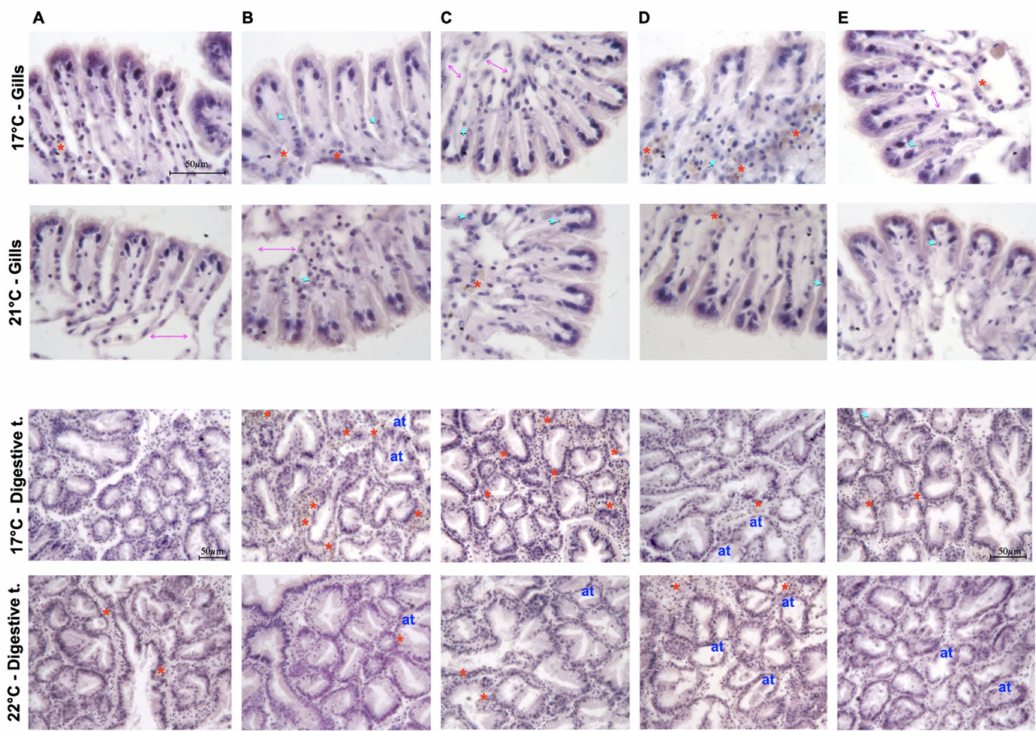
Figure 2. Micrographs of di ff erent tissues in Ruditapes philippinarum exposed to di ff erent treatments stained with haematoxylin. (i) Gills: haemocytes infiltration (light blue arrows), evident enlargement of the central vessel (pink long arrows), abundance of lipofuscin aggregates (red asterisks); (ii) digestive tubules: haemocytes infiltration (light blue arrows), abundance of lipofuscin aggregates (red asterisks) atrophied digestive tubules (blue at ). Scale bar = 50 µ